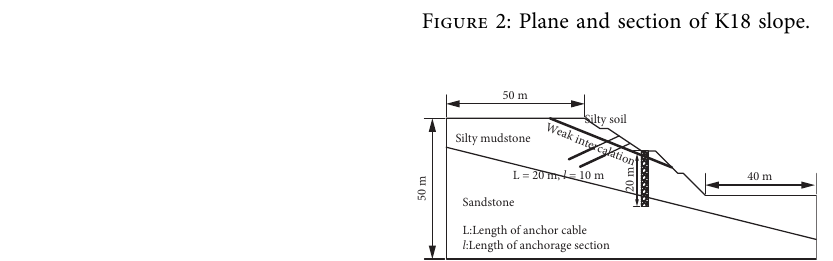
Figure 2: Plane and section of K18 slope.